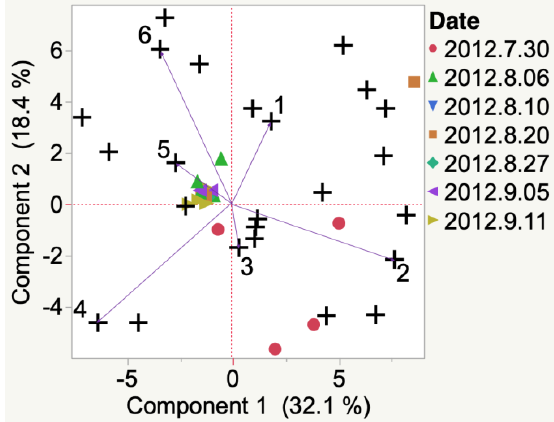
Figure 3. Evolution of VOCs emitted from whole clusters of 2012 Frontenac grapes grown in South Dakota from veraison to harvest. Key to most representative volatiles from HCA, shown as vectors from the origin and read clockwise: 1 = 2-Methyl-3-penten-2-one, 2 = Nonanal, 3 = Benzyl alcohol, 4 = Toluene, 5 = Acetic acid, 6 = 3-Phenyl-2-propenal. 2.2.1.2. Marquette